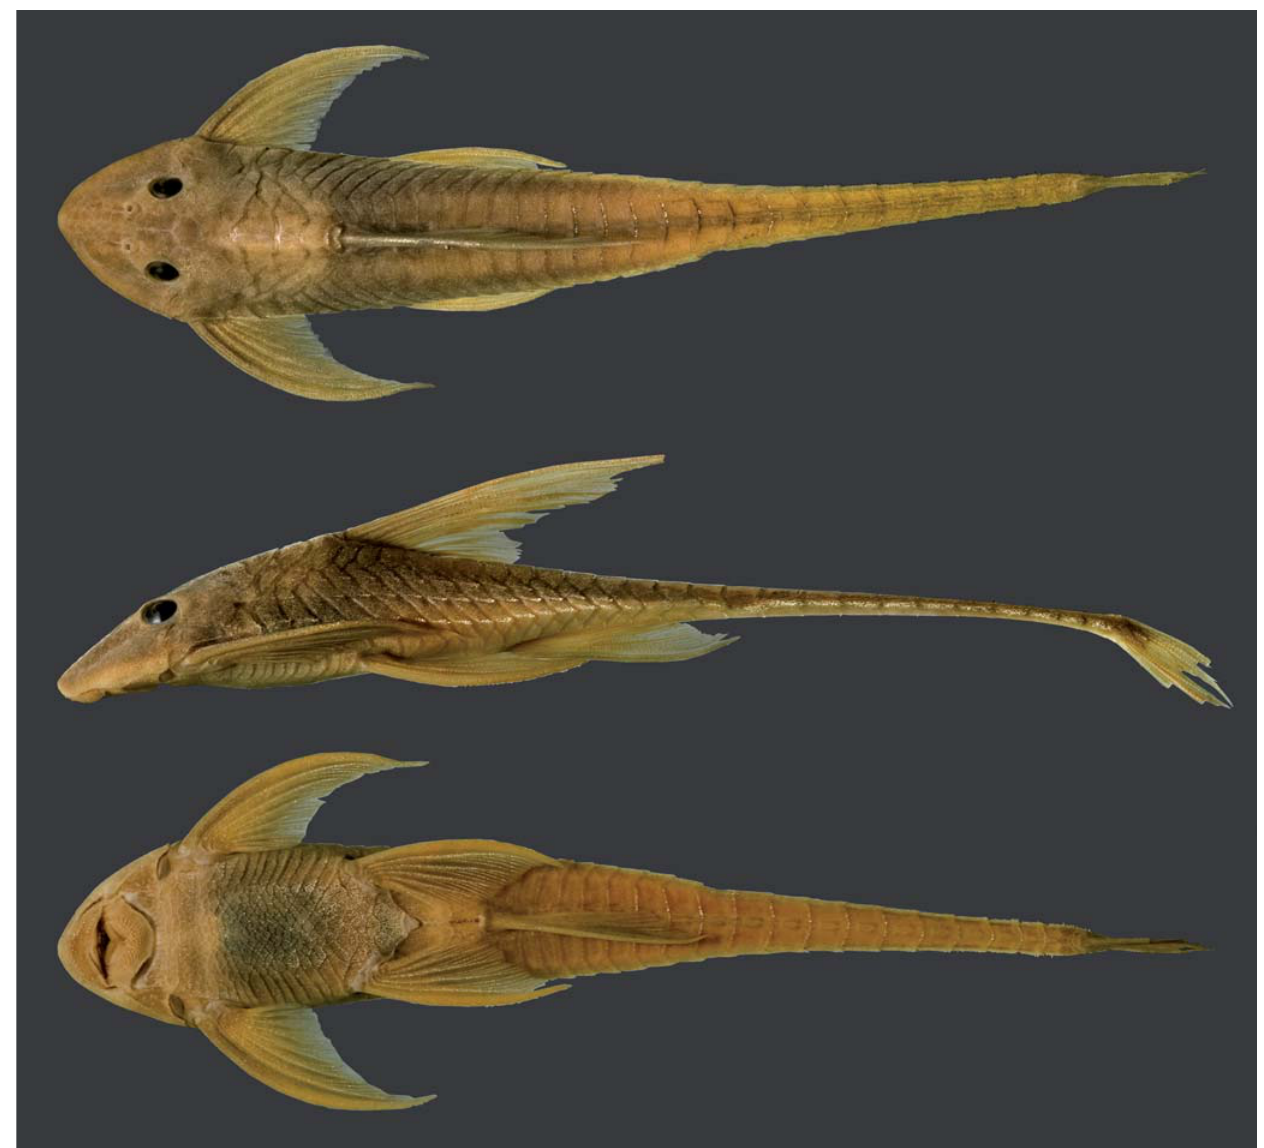
Fig. 11. Lamontichthys llanero , MZUSP 85799, 106.4 mm SL. Dorsal, lateral and ventral